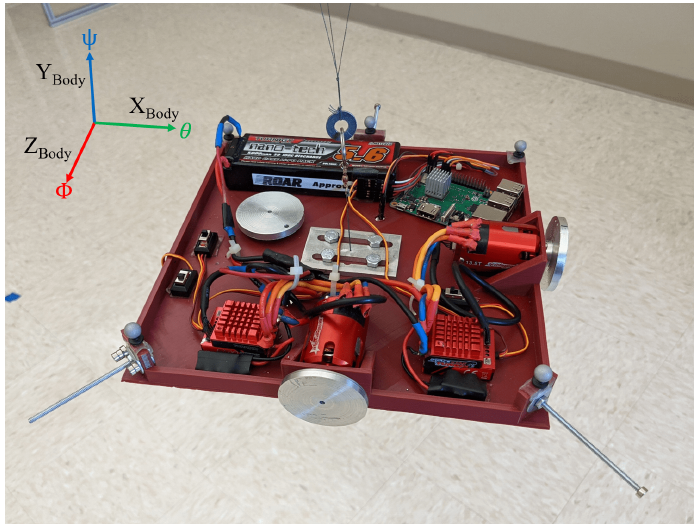
Figure 2. START and Body-fixed reference